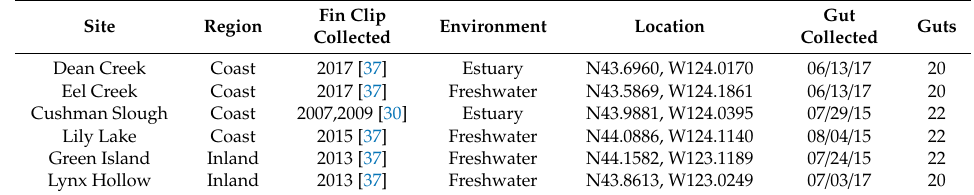
Figure 1. Site map in Oregon. Filled and open points represent freshwater and estuary, respectively. Two inland freshwater populations and four coastal populations were sampled. Table 1. Sample collection details for sites along the coast and inland in